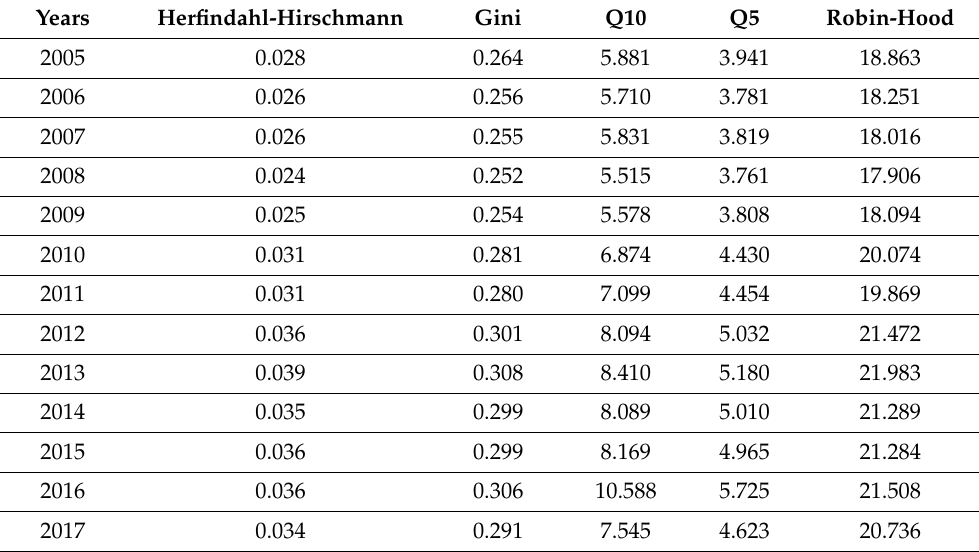
Table 4. Changes in net income inequality distribution indices between 2005 and 2017, all households.